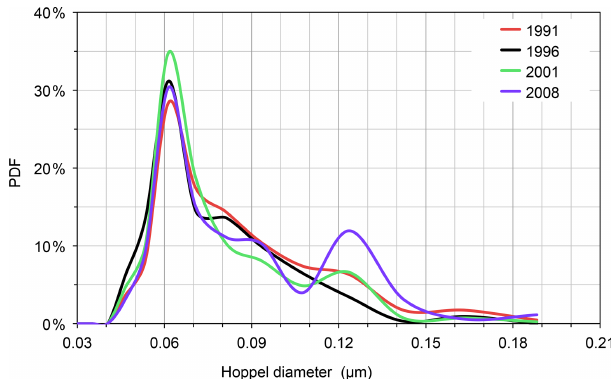
Figure 17. Probability density function (PDF) of the Hoppel diam- eter shown for four different expeditions in the high Arctic, in the summers of 1991, 1996, 2001 and 2008. Further details on the qual- ity and data processing of the aerosol size resolved measurements are available in Heintzenberg and Leck